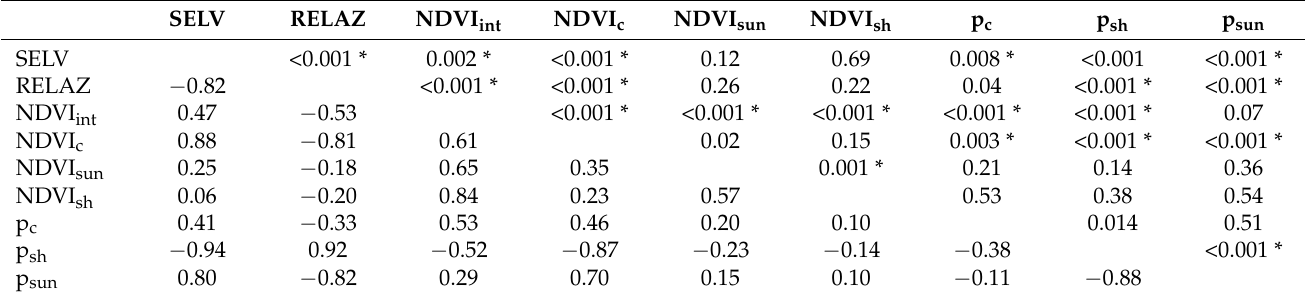
Table 2. Pearson correlation coefficients between all variables, including factors affecting the illumination direction.